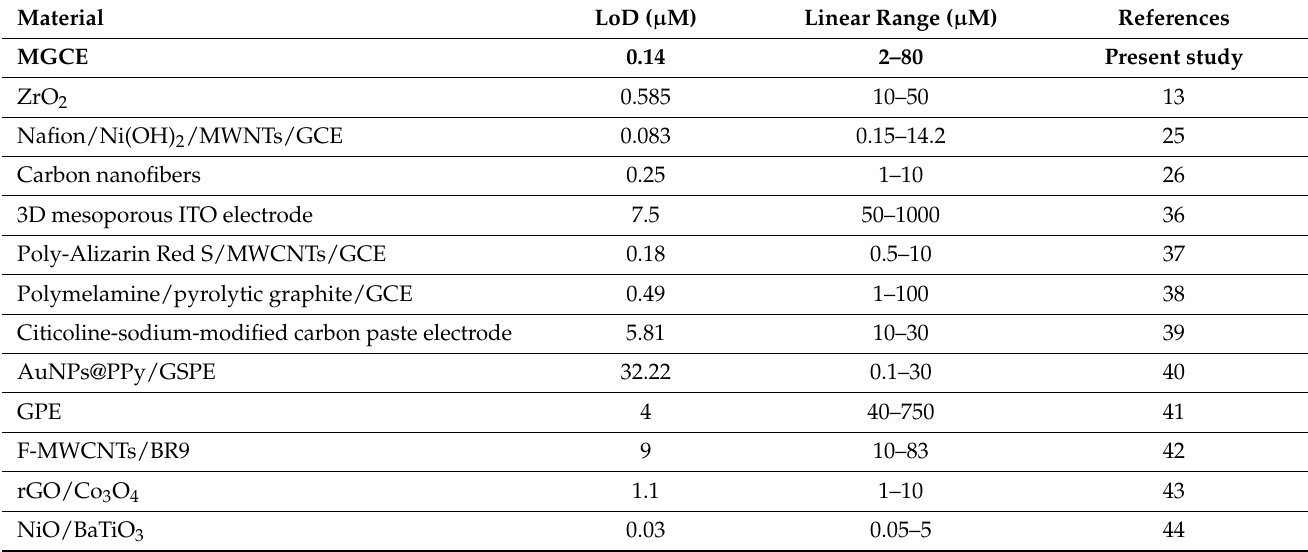
Table 1. Comparison of LoD and linear range of MGCE with previous reports